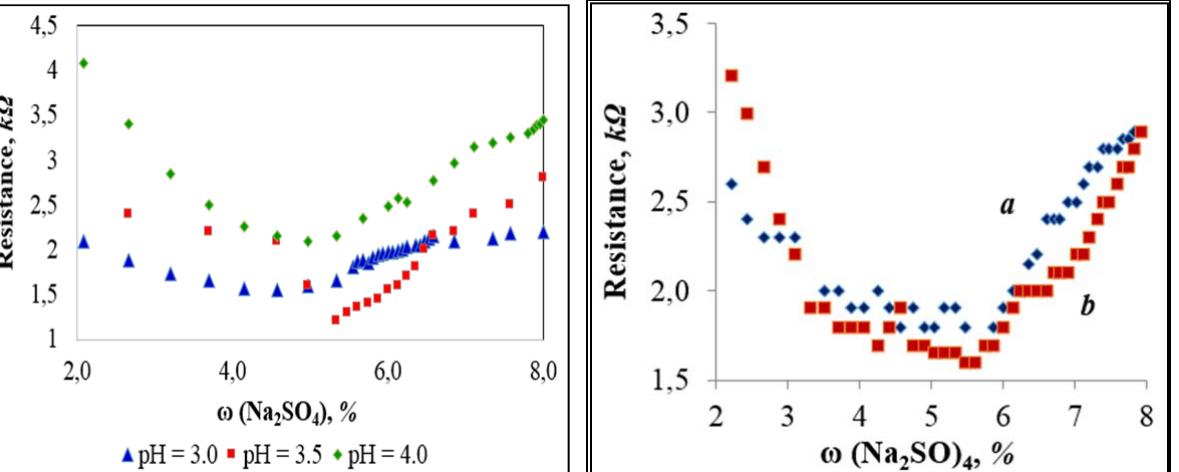
Figure 4. Resistance of Na SO solutions at Figure 5. Resistanse of sodium sulfate 2 4 various pH values solution ( a ); in the presense of gelatine ( b